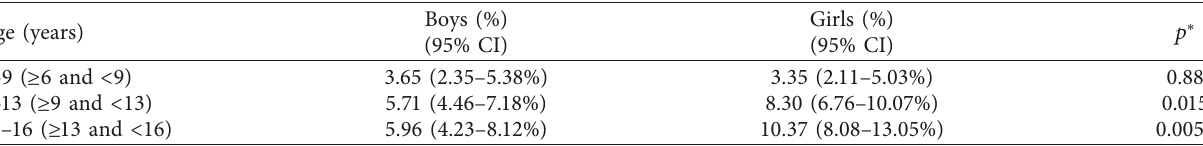
Table 3: Prevalence of myopia defined as spherical equivalent of at least − 0.5D among examined boys and girls.